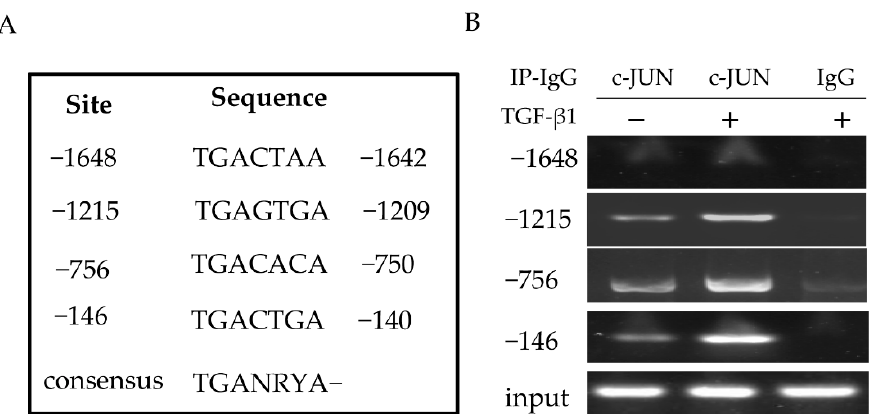
Figure 3. Construction of pFcRn promoter luciferase reporter plasmids. ( A ) Schematic diagram of the pFcRn promoter region and luciferase reporter plasmid. ( B ) IPEC-J2 cells were co-transfected with a series of truncated pFcRn promoter constructs ( − 1740 to +350, F1 to F9) and luciferase reporter vector (pRL-TK-luc), and its luciferase activity was measured. ( C ) IPEC-J2 cells were co-transfected with pFcRn luciferase reporter plasmids and the pRL-TK-luc vector, incubated with TGF- β 1 (8 ng/mL) for 12 h, and luciferase activity was quantified; * p < 0.05, ** p < 0.01.